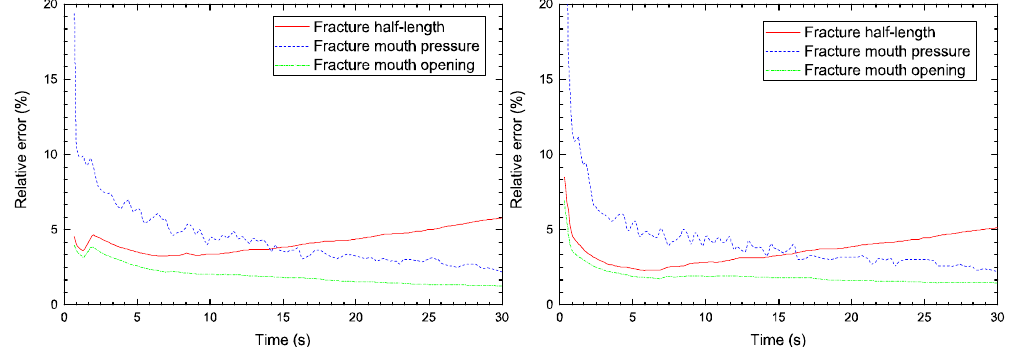
Figure 10. Relative error for the fracture width, the fracture half-length, and the fracture mouth pressure using: ( left ) the FVM-XFEM method and ( right ) the Carrier et al. [22] model.